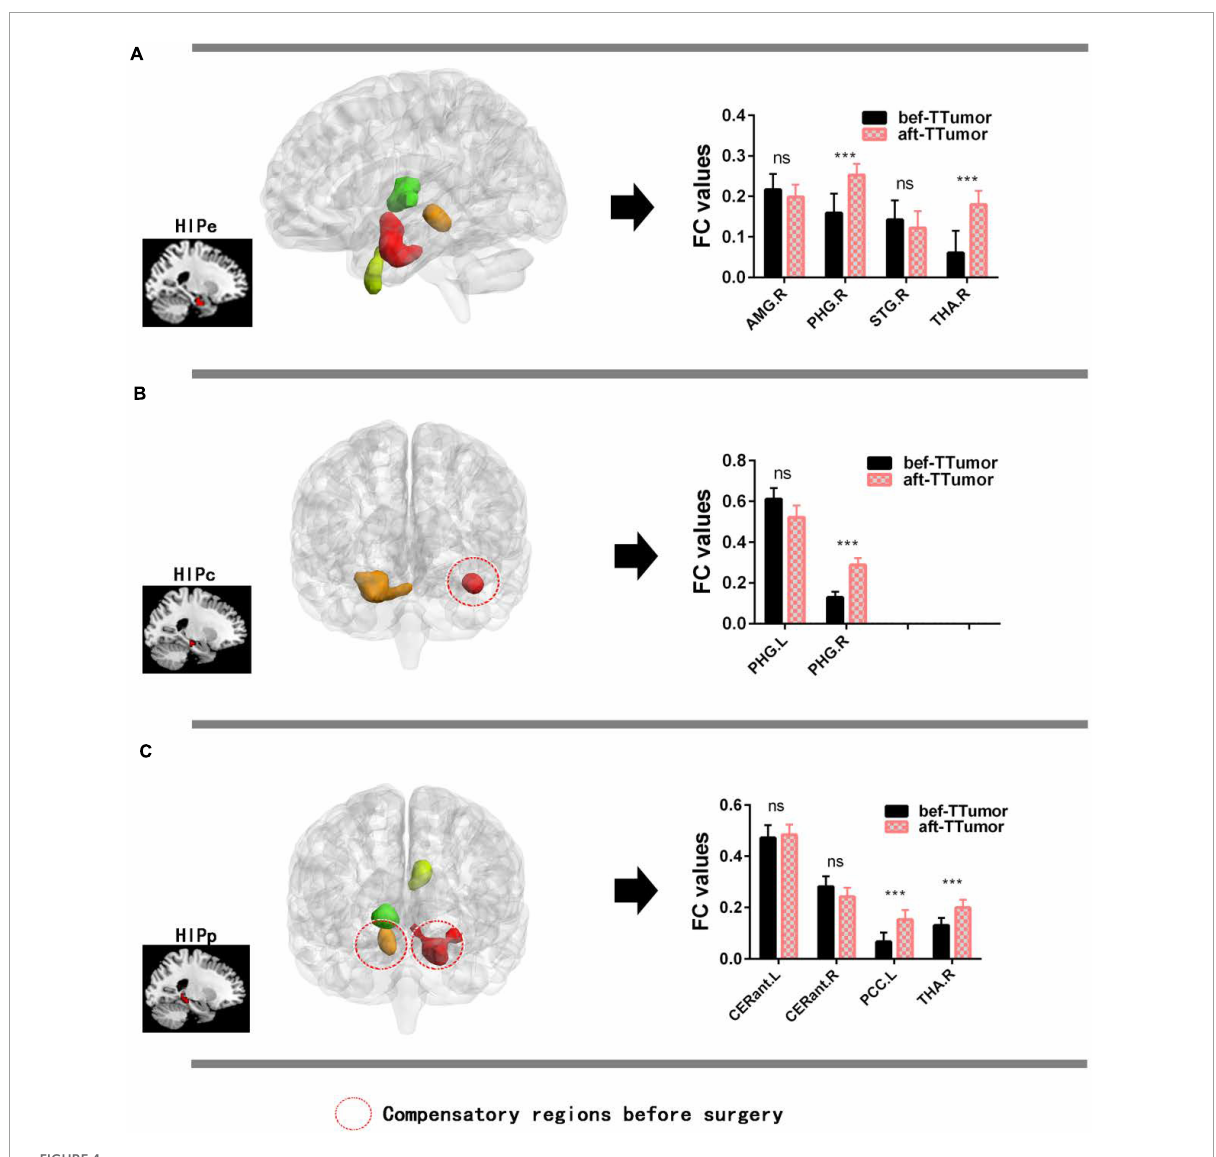
FIGURE4 Changes on FC of altered hippocampal subnetworks in TTumor patients between before and after surgery in the second cohort controlling for age, sex, and education. (A) Bar chart showing quantitative effects on the HIPe subnetwork of TTumor patients after surgery after controlling for age, sex, and education. (B) Bar chart shows the quantitative effects on the HIPc subnetwork of TTumor patients after surgery after controlling for age, sex, and education. (C) Bar chart demonstrating the quantitative effects on HIPp subnetwork of TTumor patients post-surgery after controlling for age, sex, and education; ns, not significant. *** p < 0.001. Red circle indicates compensatory regions before surgery. CN, healthy controls; TTumor, patients with temporal tumor (glioma); HIPe, hippocampal emotional region; HIPc, hippocampal cognitive region; HIPp, hippocampal perceptual region; FC, functional connectivity; bef-TTumor, patients with temporal tumor (glioma) before surgery; aft-TTumor, patients with temporal tumor (glioma) after surgery; AMG.R, right amygdala; PHG.R, right parahippocampal gyrus; STG.R, right superior temporal gyrus; THA.R, right thalamus; PHG.L, left parahippocampal gyrus; CERant.L, left cerebellum anterior lobe; CERant.R, right cerebellum anterior lobe; PCC.L, left posterior cingulate